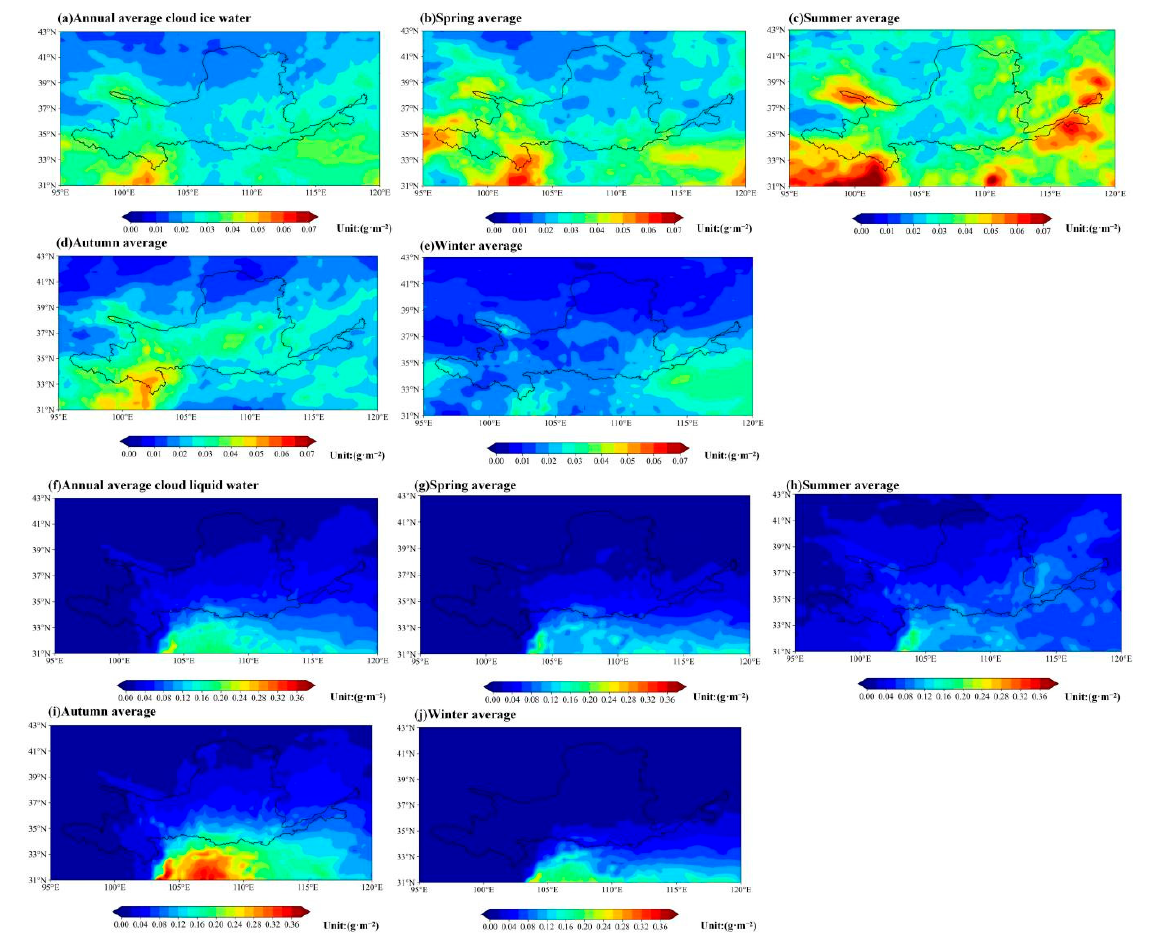
Figure 3. Annual and seasonal average distributions of cloud ice water and cloud liquid water in the Yellow River Basin from 1980 to 2019. (( a ): Annual average cloud ice water; ( b ): Spring average cloud ice water; ( c ): Summer average cloud ice water; ( d ): Autumn average cloud ice water; ( e ): Winter average cloud ice water; ( f ): Annual average cloud liquid water; ( g ): Spring average cloud liquid water; ( h ): Summer average cloud liquid water; ( i ): Autumn average cloud liquid water; ( j ): Winter average cloud liquid water).